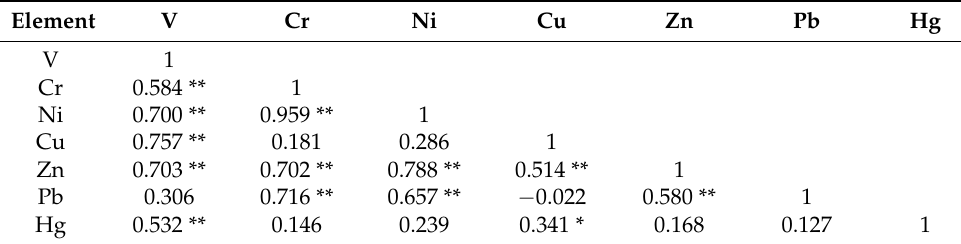
Table 9. Pearson correlation coefficients for the soil metals.